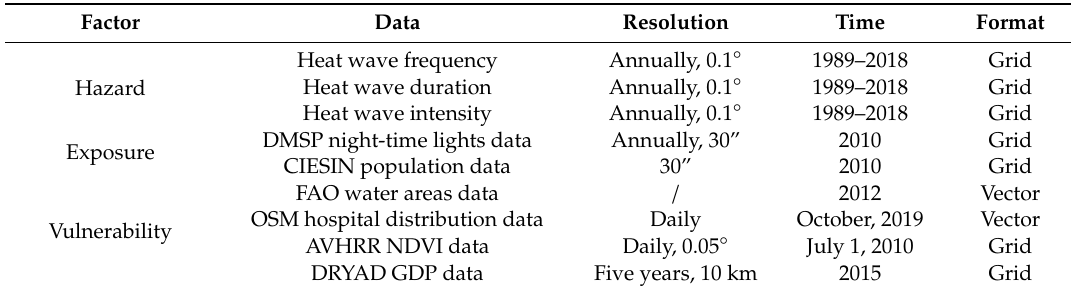
Table 2. Hazard, exposure and vulnerability factors.